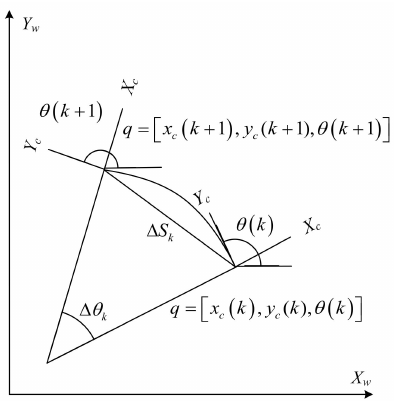
Figure 5. Odometer model.